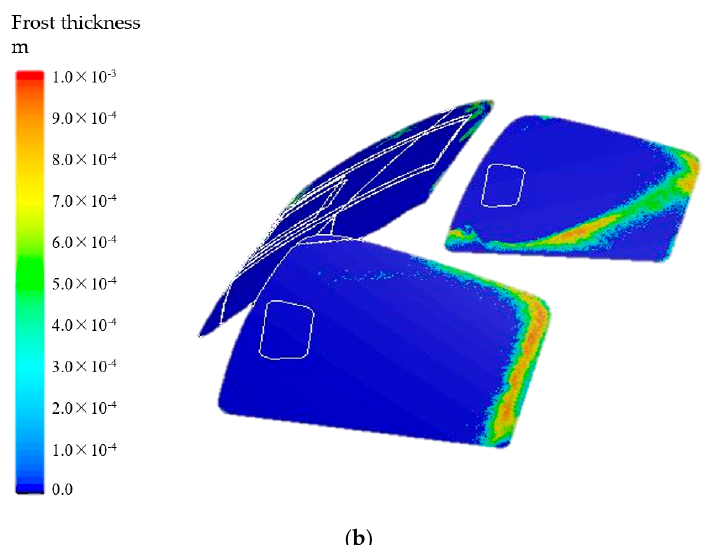
Figure 9. Frost thickness of windshield surface at 25 min after optimization. ( a ) Front windshield; ( b ) side windshield.